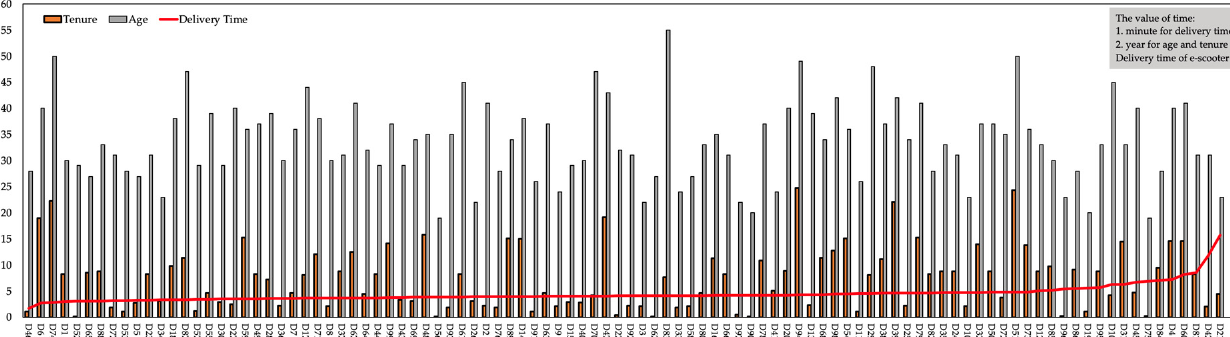
Figure 2. The sort of the delivery drivers based on the delivery time by e-scooter. The technical specifications of the preferred e-scooter ranges for the distribution process are shared in Figure 3.